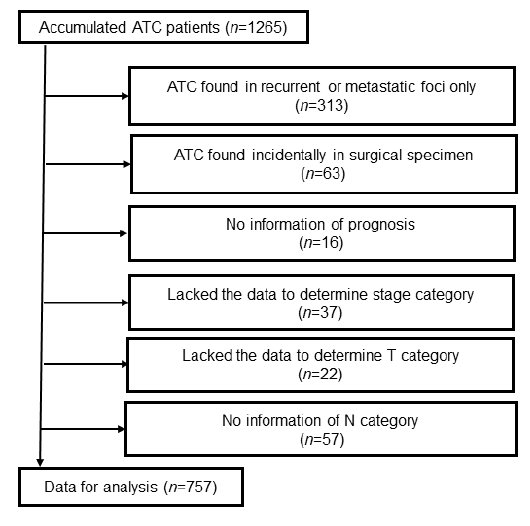
Figure 1. Cohort Figure 1. Cohort diagram.